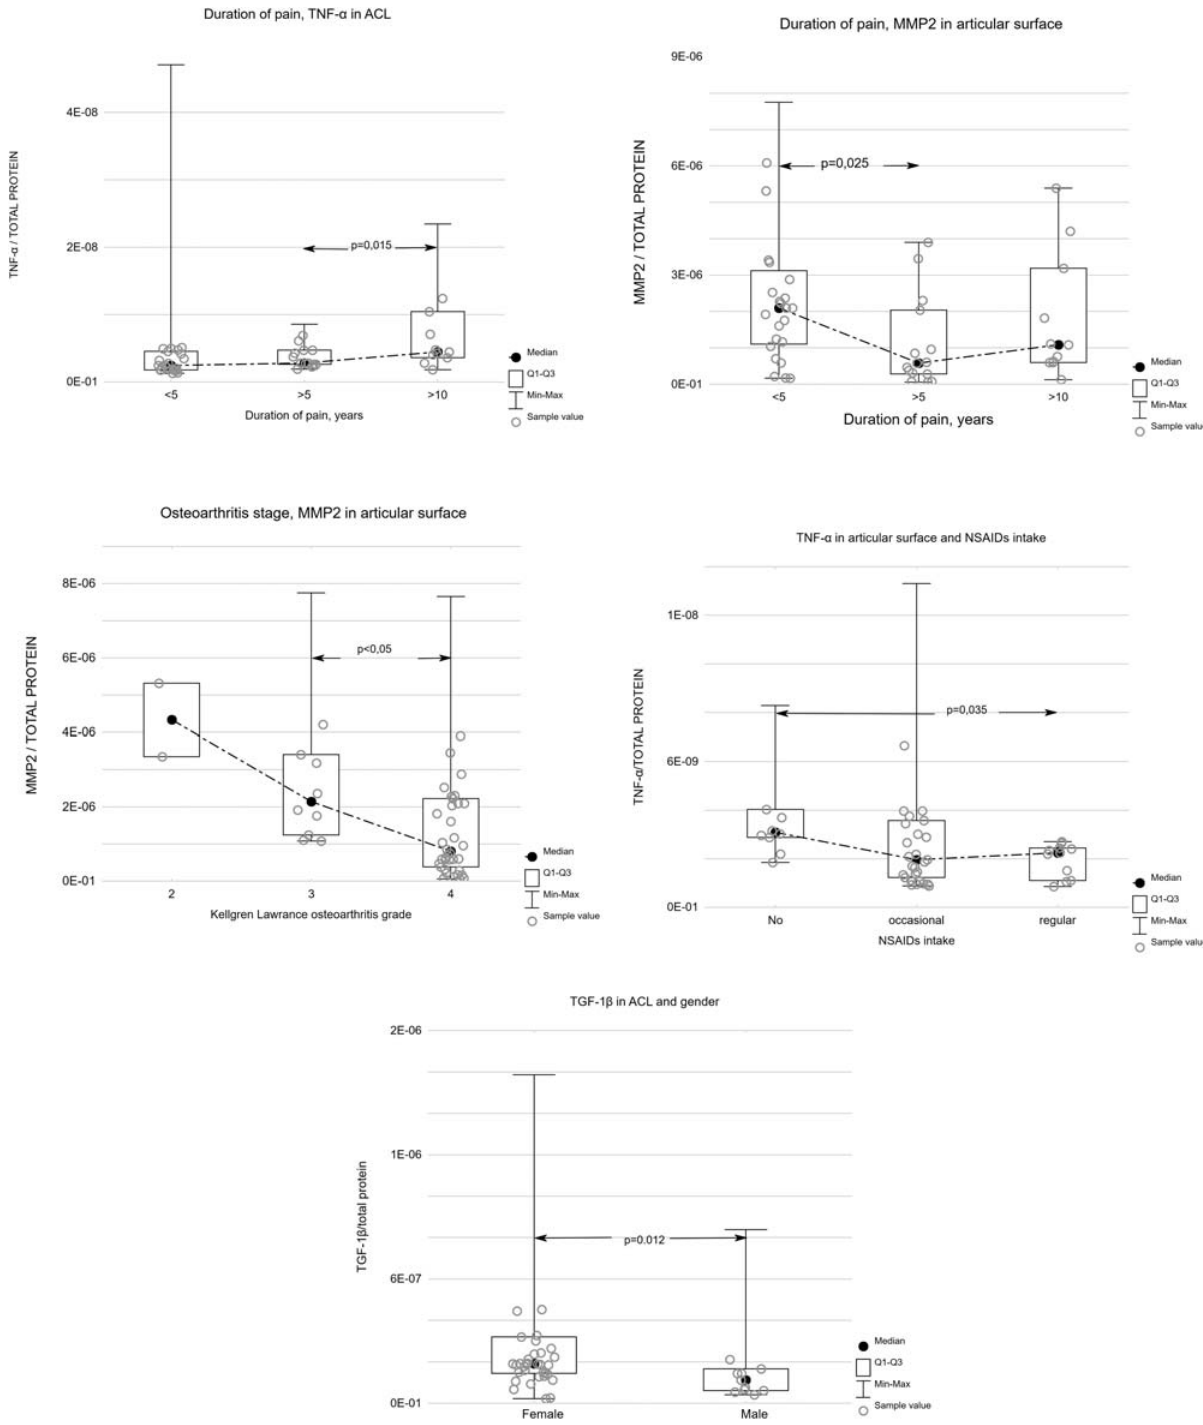
Figure 2: Demographic medical history data and evaluation of OA stage. Concentration of investigated proteins ( pg/ml ) corrected with respect to overall protein concentration in anatomical structures ( pg/ml )